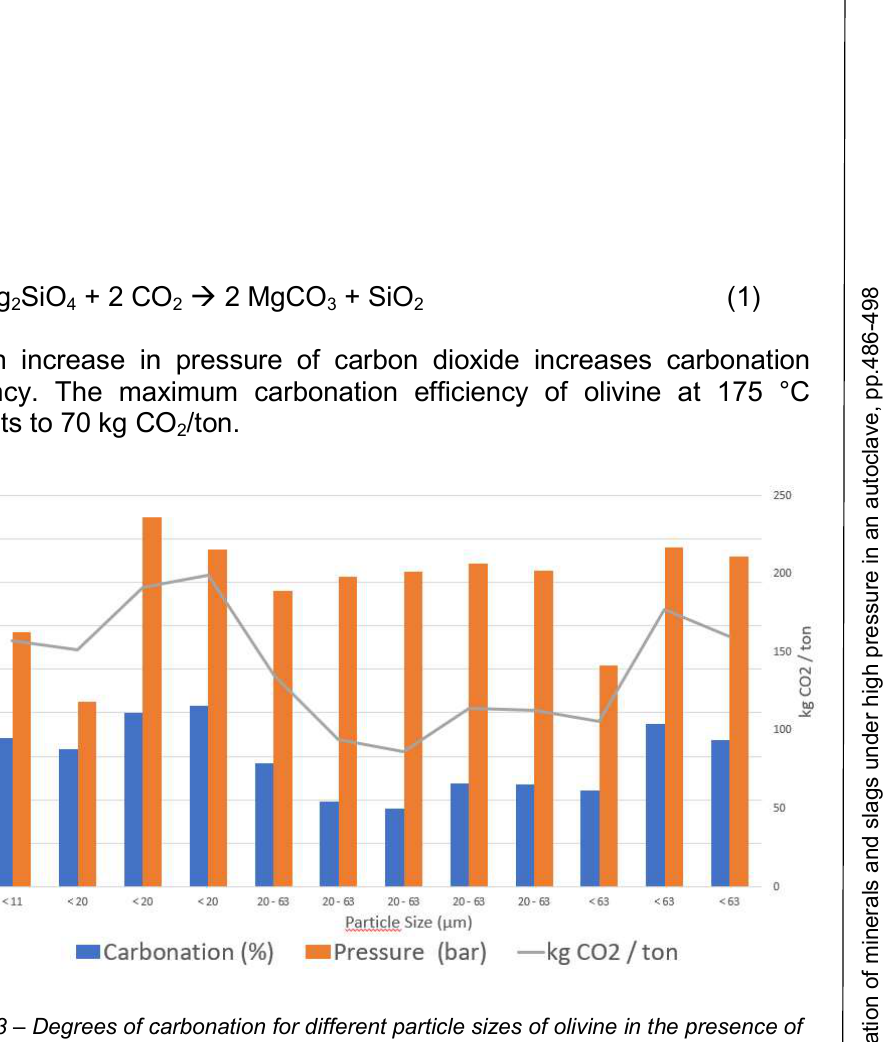
Figure 3 – Degrees of carbonation for different particle size Рис. 3 – Степень